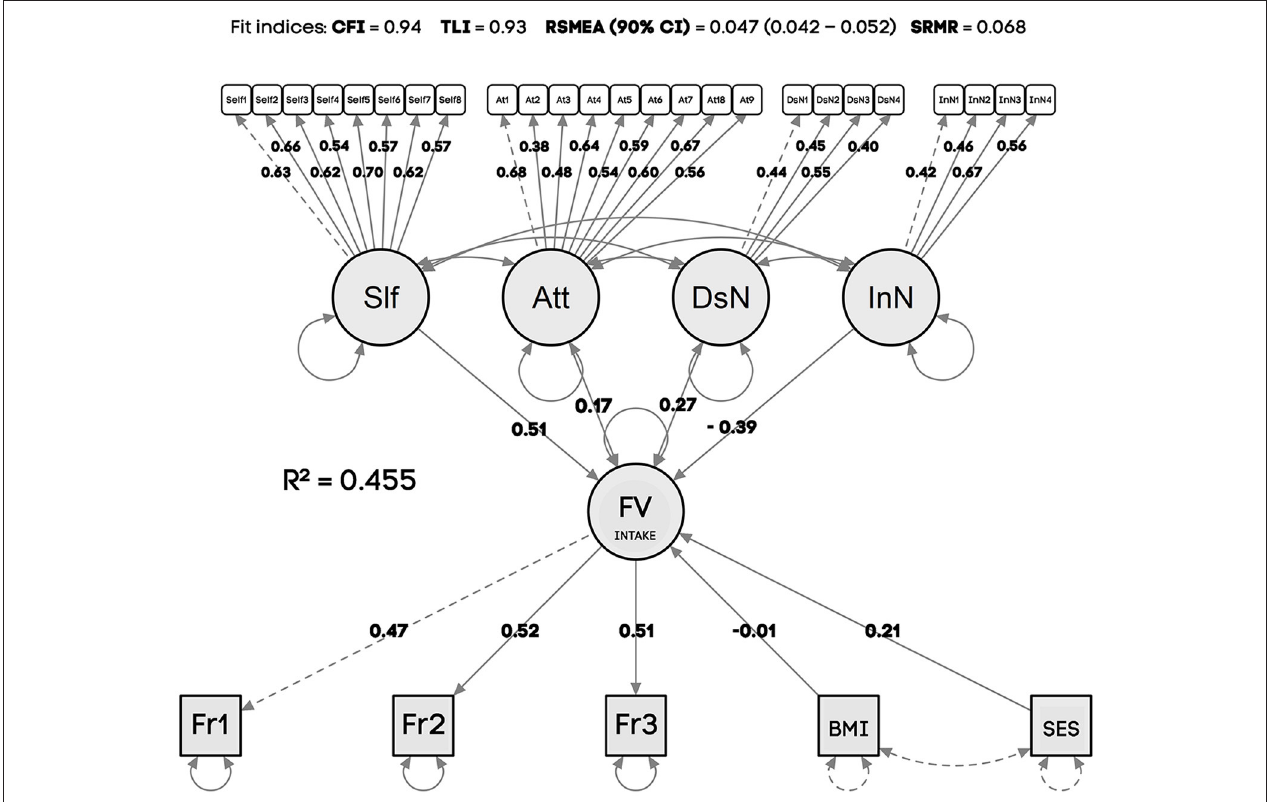
FIGURE 2 | Prediction model for weekly frequency of Fruit and Vegetable Intake regarding psychosocial determinants, SES, and BMI. R-Square ( R 2), Variance explained by the model; CFI, Comparative Fit Index; TLI, Tucker-Lewis Index; RMSEA, Root Mean Square Error of Approximation [90% confidence interval (CI)]; SRMR, Standardized root mean square residuals; BMI, Body Mass Index; SES, Socioeconomic Status. Numbers in bold: factor loadings. Dashed lines represent non-standardized estimates that were constraint to one as reference to the